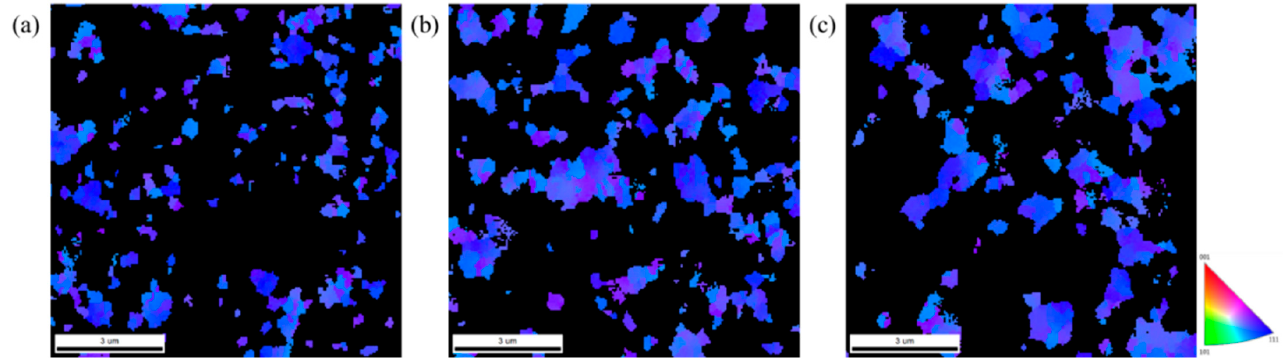
Figure 9. Plan-view EBSD (111) orientation maps (OIMs) of the 15- μ m thick nt-Cu foils electroplated with different concentrations of Cu 2+ : ( a ) 0.3 M; ( b ) 0.5 M; ( c ) 0.8 M.